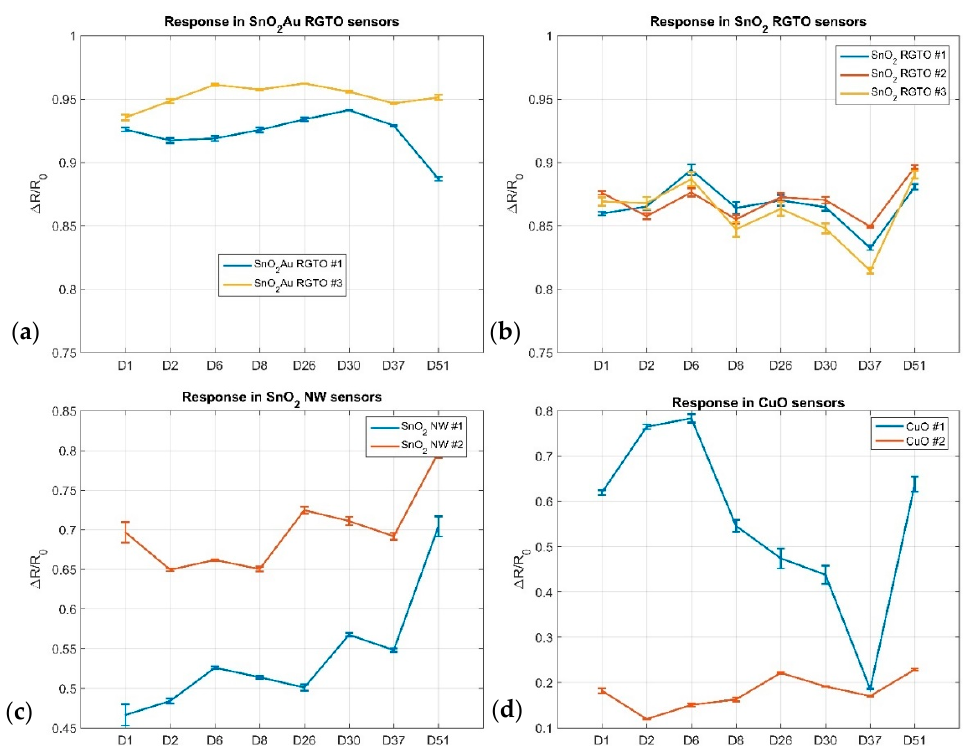
Figure 3. ∆ R / R 0 for all the sensors from day 1 to day 51. ( a ) Response of 2 out of 3 SnO 2 Au RGTO sensors; ( b ) response of the 3 SnO 2 RGTO sensors; ( c ) response of the 2 SnO 2 NW sensors; ( d ) response of the 2 CuO sensors.